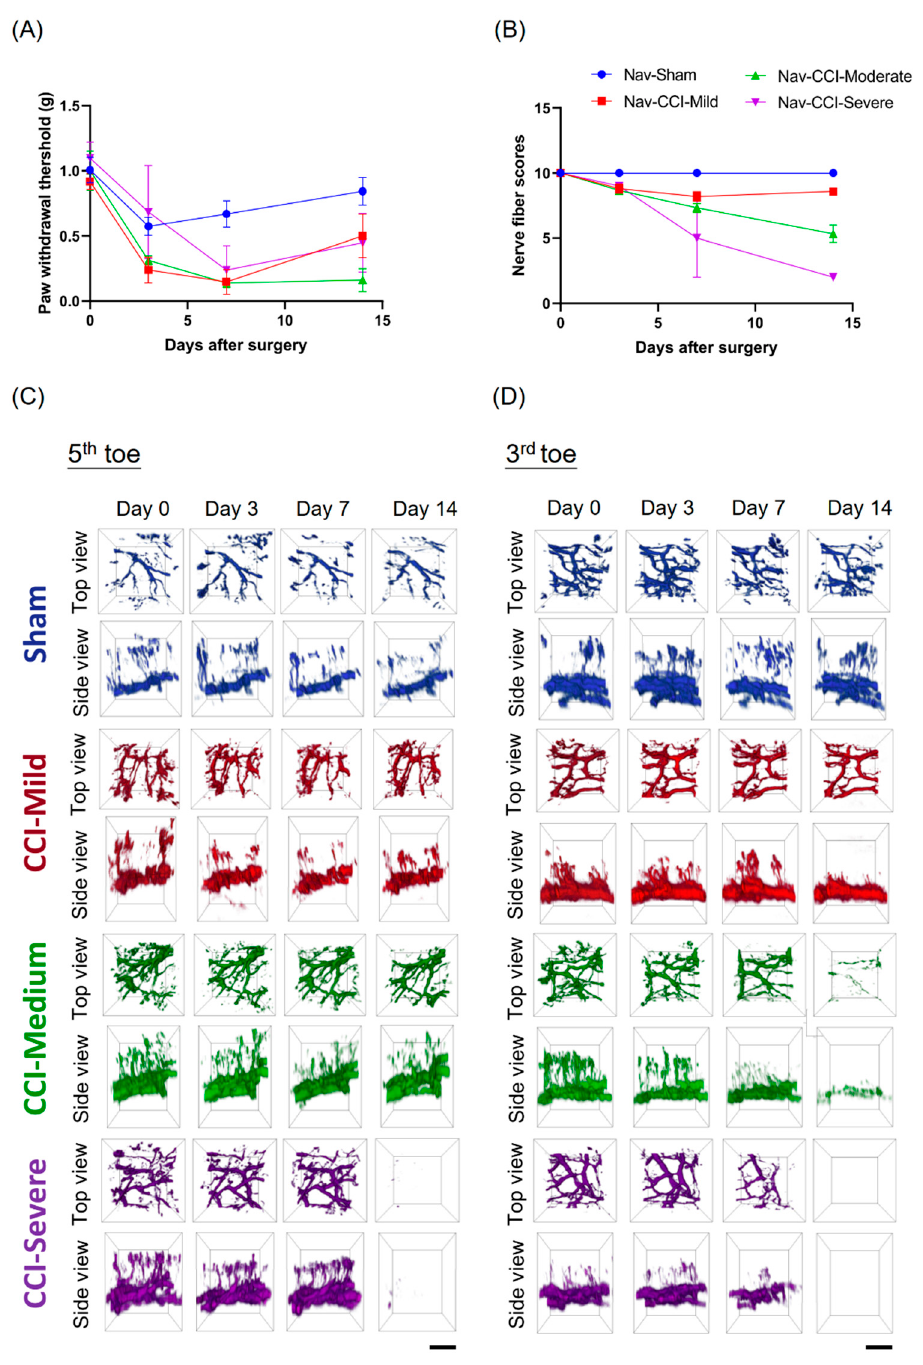
Figure 3. Association between nerve scores, intravital images and mechanical threshold. Mechanical hypersensitivity did not associate with nerve-injury severity. ( A ) The Nav1.8-tdTomato mice exhibited mechanical hypersensitivity and ( B ) the corresponding nerve scores after CCI surgery. The CCI-treated mice were divided into three subgroups according to nerve score: CCI-mild: 7–9; CCI-moderate: 3–6; and CCI-severe, 0–2. ( C ) Time-lapse observations of the fifth and ( D ) third toes in Nav1.8-tdTomato mice. Intravital microscope images showed that the mice had varying degrees of nerve degeneration in the nerve plexus and terminals, which corresponded with the severity of the CCI injury. Notably, the mice in the CCI-moderate group exhibited higher mechanical hypersensitivity than those in the CCI-mild and CCI-severe groups. Day 0 indicates baseline; scale bar: 50 µ m.